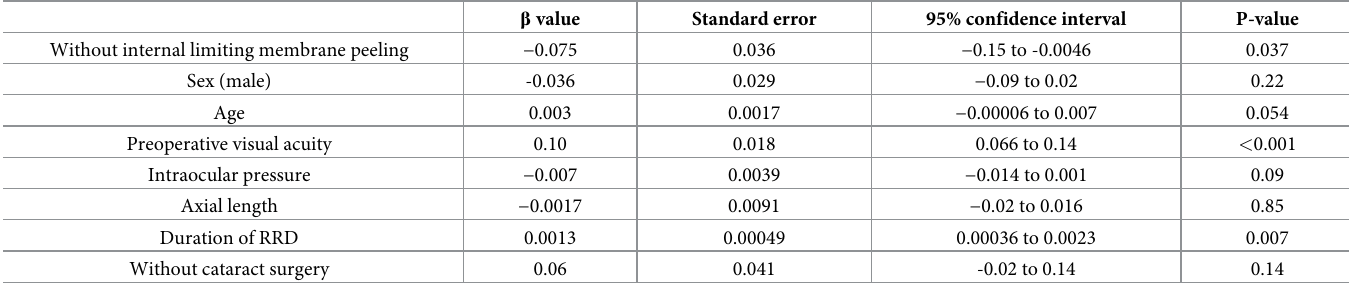
Table 4. Multiple linear regression analysis for VA at 6 months postoperatively in the eyes with a macula-off Rhegmatogenous Retinal Detachment